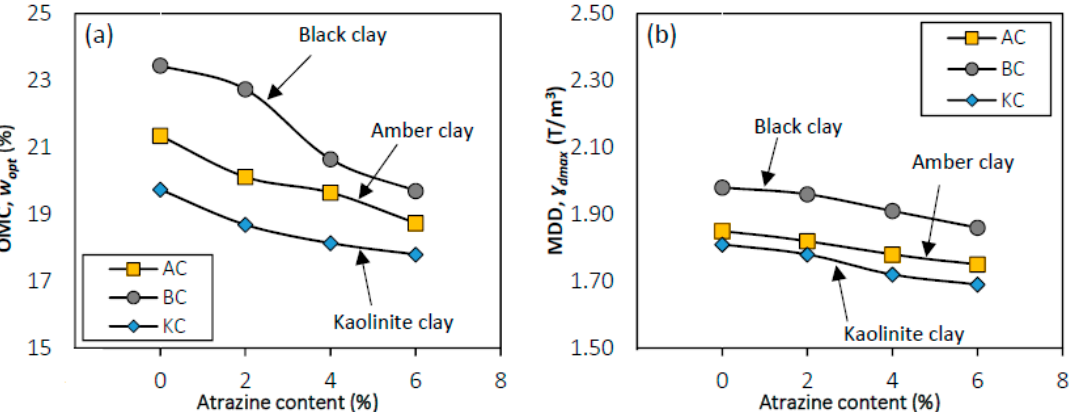
Figure 7. Compaction test results for Amber Clay (AC), Black Clay (BC) and Kaolinite Clay (KC) specimens contaminated at different Atrazine contents (a) Optimum moisture content (OMC) versus Atrazine content; (b) Maximum dray density (MDD) versus Atrazine content.